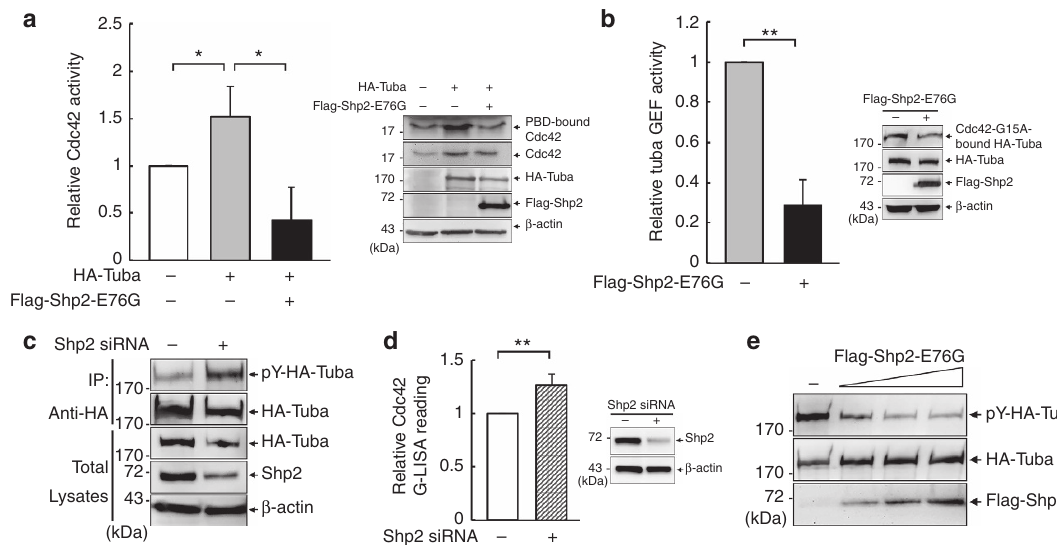
Figure 2 | Regulation of Tuba-mediated Cdc42 activation by Shp2. ( a , b ) HEK293T cells were transfected with HA-Tuba in the presence or absence of Flag-Shp2-E76G as indicated. Cells were harvested for ( a ) GST-PBD pull-down assay to determine endogenous Cdc42 activity, and ( b ) GEF activity of HA-tuba by GST-Cdc42-G15A pull-down assay. The representative Western blots for the assays are shown on the top. The relative Cdc42 and HA-Tuba GEF activity from three independent experiments are shown below. Data are presented as mean ± s.d.; Two-tailed unpaired Student’s t -test was performed, * P o 0.05, ** P o 0.01. ( c ) HEK293Tcells were transfected with or without Shp2 siRNA for 3 days, followed by transfection with the expression construct of HA-Tuba. HA-Tuba protein was immunoprecipitated with anti-HA beads for western blotting with anti-phosphotyrosine (4G10) and anti-HA antibodies. The total lysates were also subjected to Western blot analysis as indicated. ( d ) Cdc42 activity was measured by G-LISA assay in cells with and without Shp2 knockdown. Values are mean ± S.D from three independent experiments. ** P o 0.01 based on 2-tailed unpaired Student’s t test. ( e ) Immunoprecipitated HA-Tuba protein from pervanadate-treated cells was incubated with increasing amounts of immunopurified Flag-Shp2-E76G protein at 30 (cid:2) C for 30min and analyzed by western blotting as